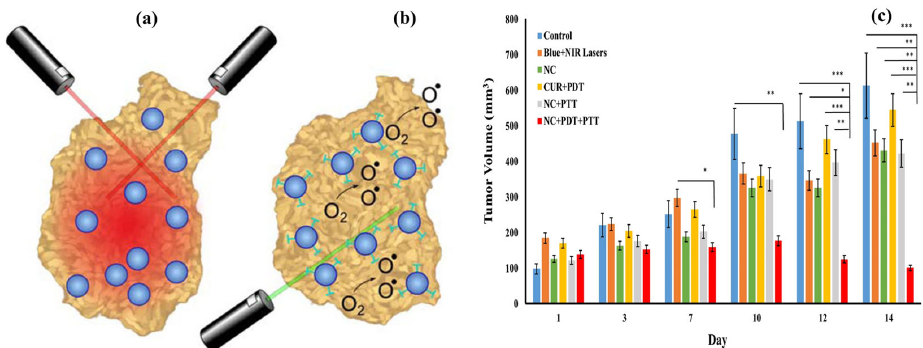
Figure 11. Tumor ablation therapies with iron oxide NPs. ( a ) In photothermal ablation, light ab ‐ sorbed by NPs is converted to thermal energy causing cell death in the vicinity. ( b ) For photody ‐ namic therapy, photosensitizing agents attached to NPs are activated by an external light source to create singlet oxygen species that are cytotoxic to cells. Reprinted from Ref. [231]. Creative Com